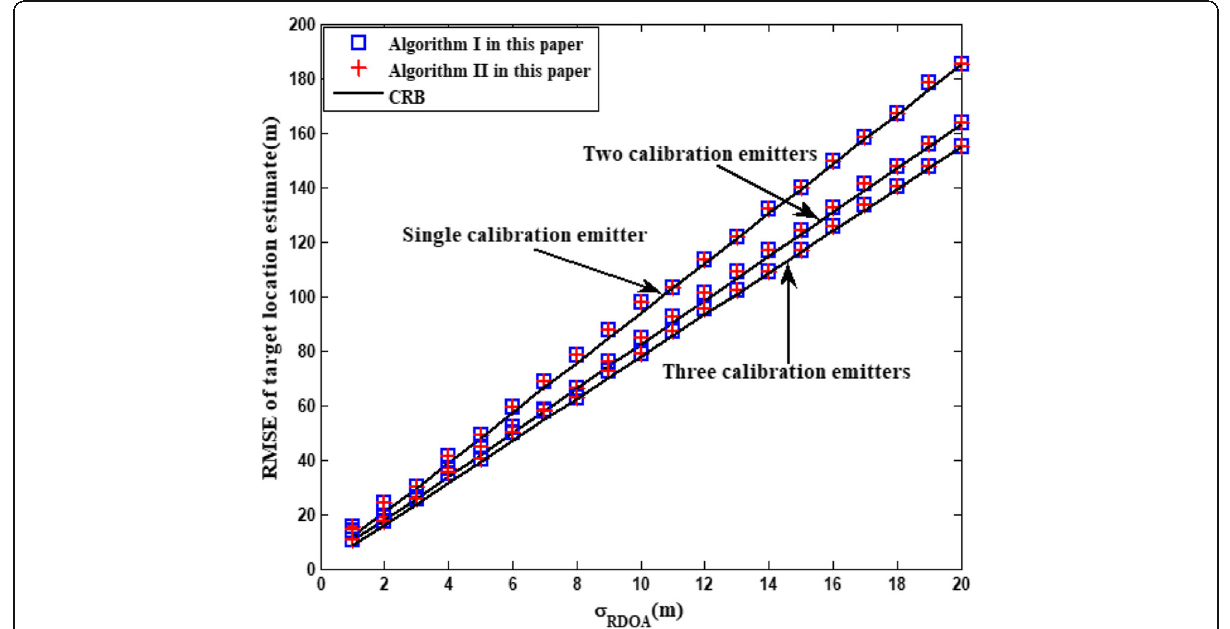
Fig. 15 RMSE of target location estimate versus σ RDOA for a different number of calibration